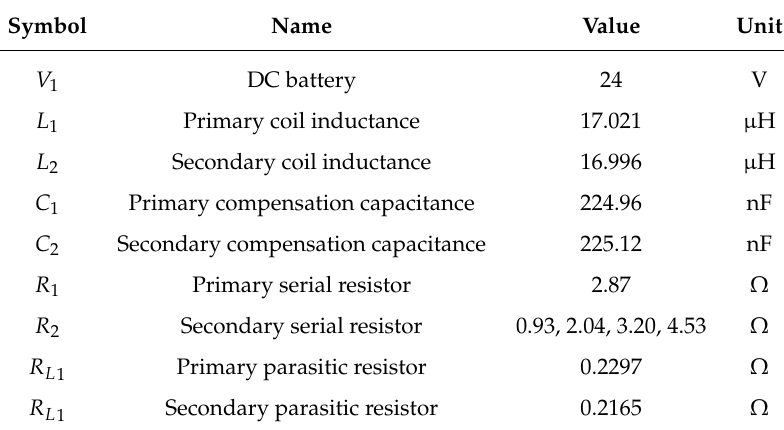
Table 5. Element parameters of the simulation schematic